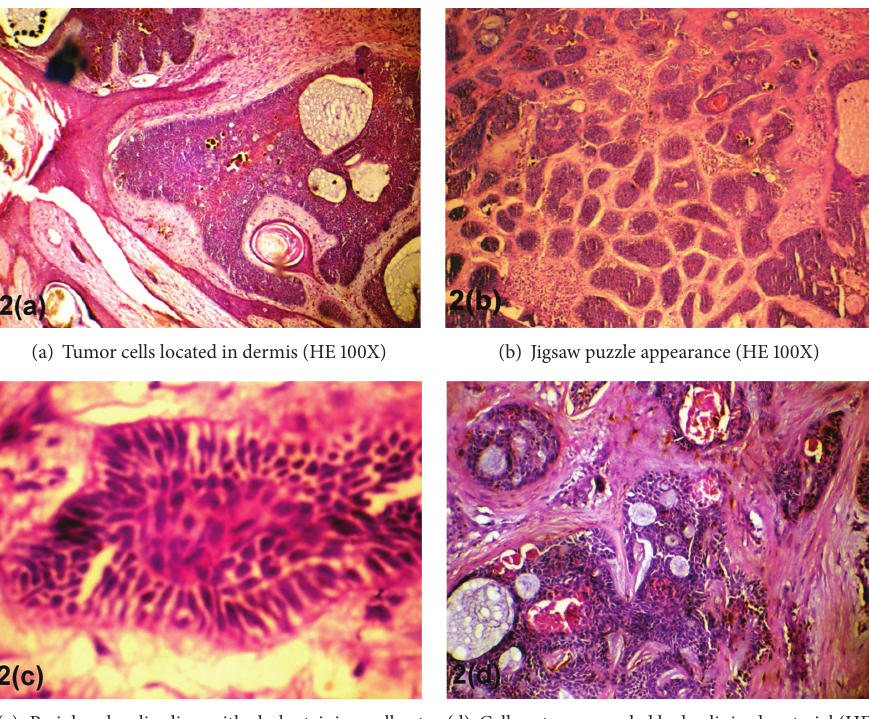
Figure 2: Histology of